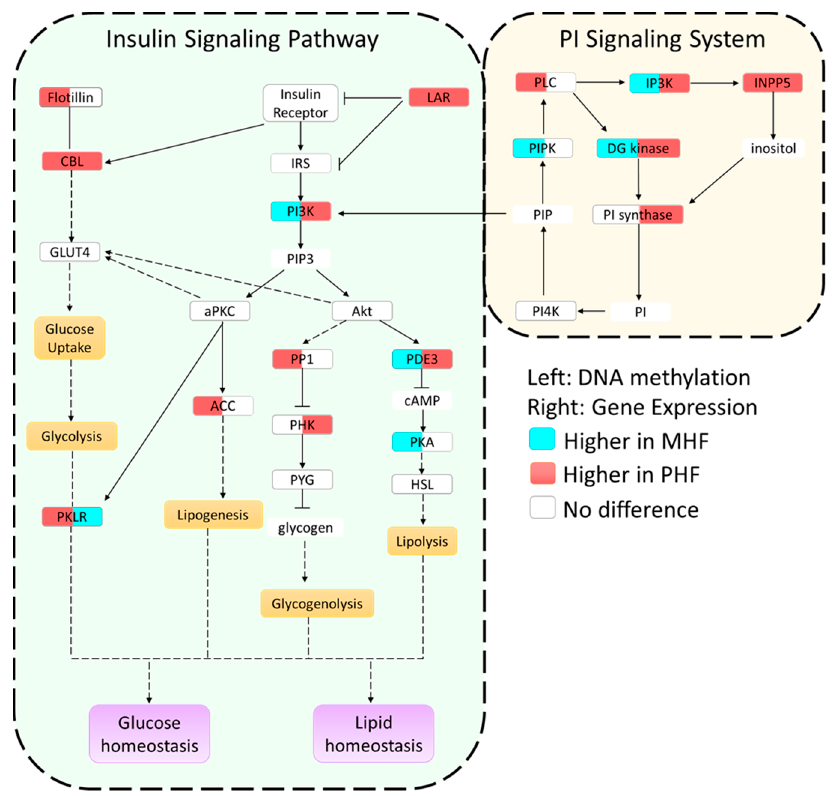
Figure 4. Summary of epigenetic and gene expression differences in the insulin and PI signaling pathways. Genes in each pathway are boxed and filled with two colors. The color in the left side of the box indicates methylation levels, while the color in the right side of the box denotes gene expression levels. White color signifies no change, blue color signifies higher methylation or expression in MHF animals, and red signifies higher methylation or expression in PHF animals. Yellow and purple boxes represent metabolic functions. A solid line represents a direct relationship, a dashed line represents a multi-step process, and compounds with no outline are other important signaling molecules.